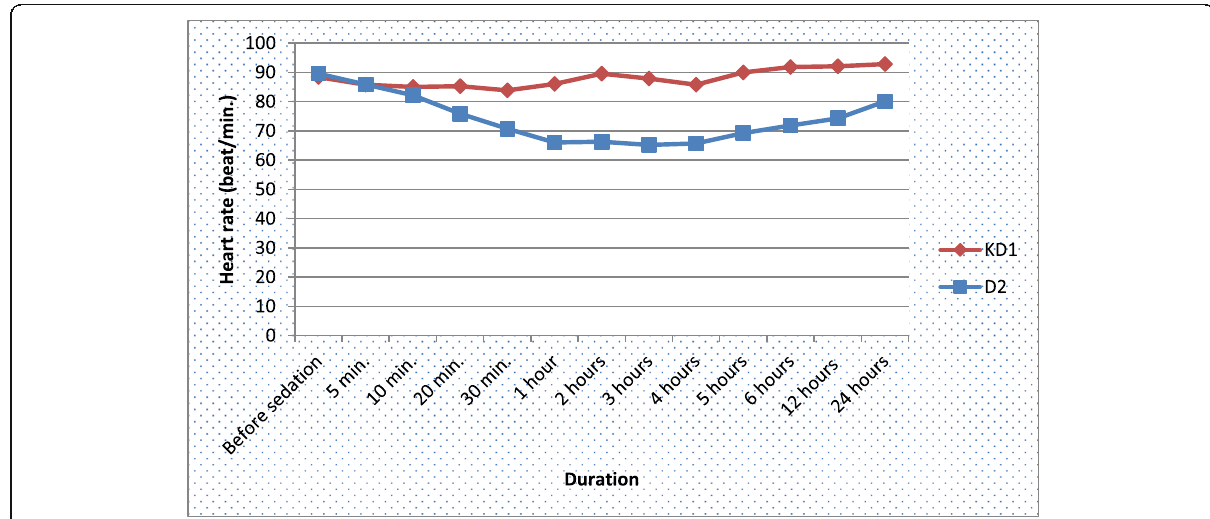
Fig. 2 Heart rate changes in the studied two groups. KD 1 , ketamine-dexmedetomidine group. D 2 , dexmedetomidine group. HR, heart rate. Statistically significant drop of HR in group D 2 compared with group KD 1 ( P value <